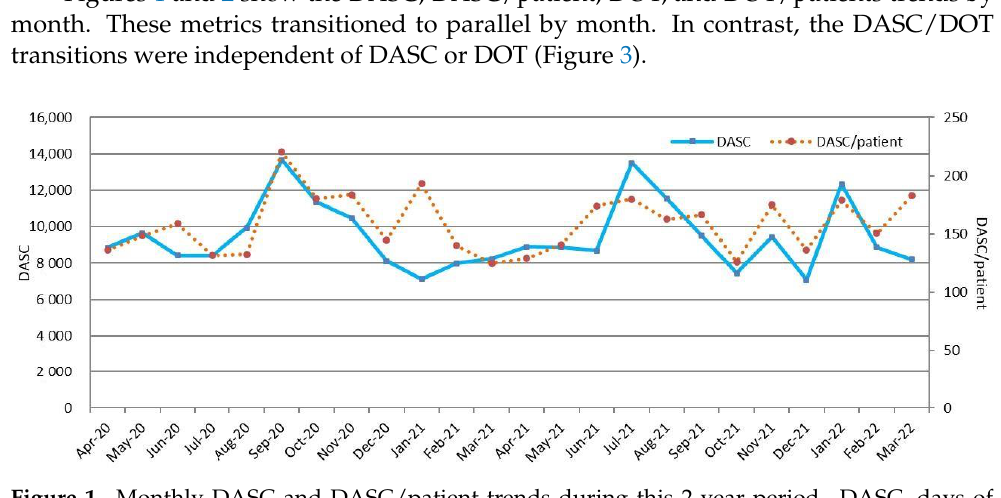
Figure 2. Monthly DOT and DOT/patient trends during this 2-year period. DOT, days of therapy. Figure 3. Monthly DASC/DOT trend during this 2-year period. DASC, days of antibiotic spectrum coverage; DOT, days of therapy. 2.3. Relationship between DASC, DOT, DASC/DOT, and BSI Patient Number by Month The relationships among DASC, DASC/patient, DOT, DOT/patient, DASC/DOT, and no. of patients per month are shown in Figure 4. A strong correlation was observed be- tween DASC and DOT, as well as DASC/patient and DOT/patient. In contrast, DASC/DOT had no correlation with other metrics.